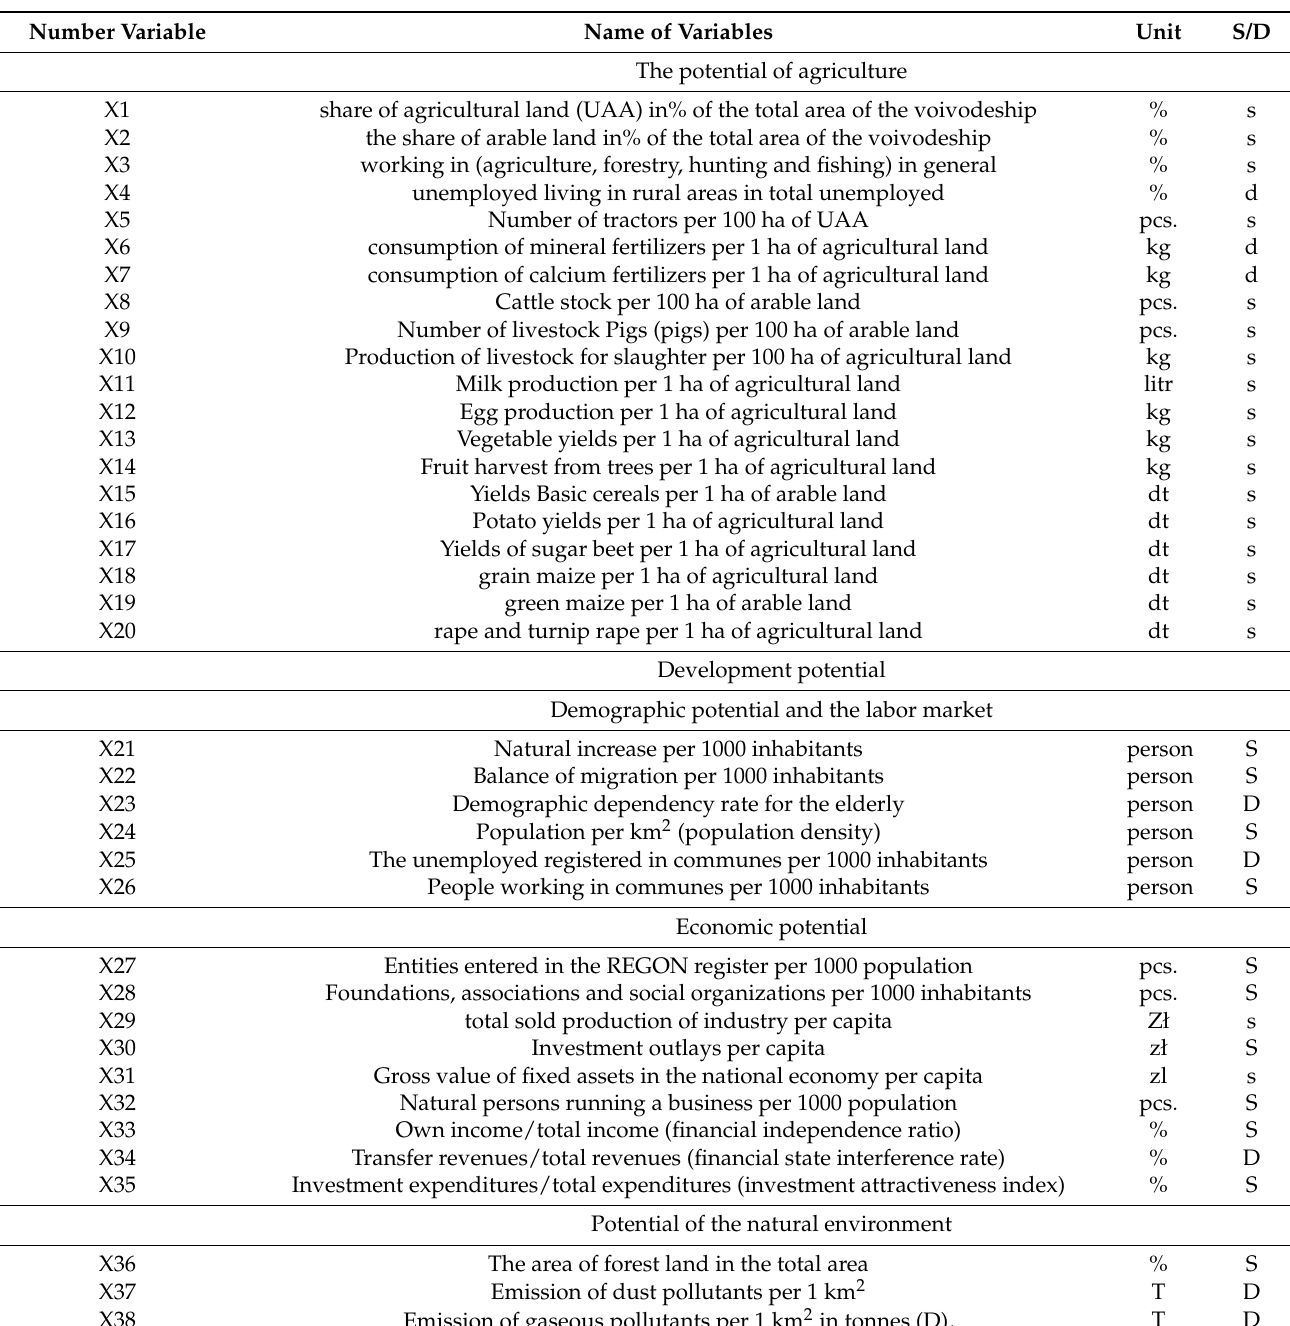
Table 1. List of variables describing the financial situation and economic and social development of